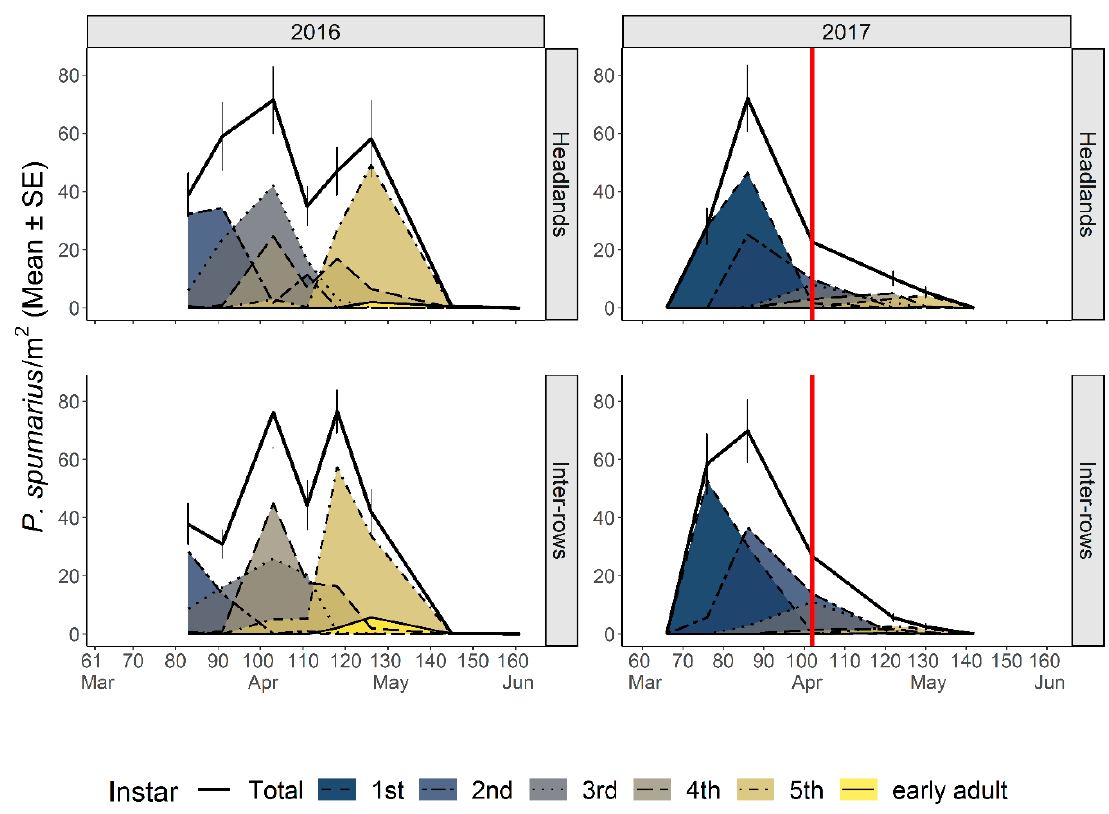
Figure 2. Life-stage structure of the preimaginal populations of Philaenus spumarius in vineyard inter-rows and headlands. The area curves of each nymphal instar, the total nymphs, and the newly emerged adults are represented as mean densities by sampling date. Red vertical lines represent the date of mowing treatment. Data refer to the 2016–2017 survey in Asti.